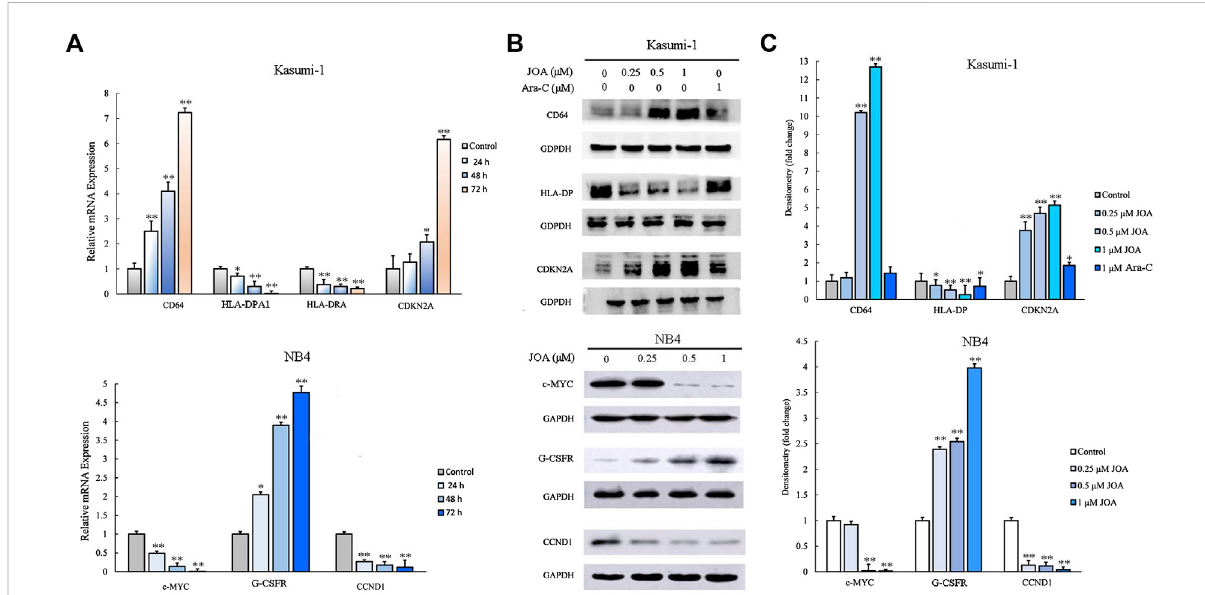
MolecularanalysisoftheeffectsofJOAondifferentiation-relatedgenesinKasumi-1andNB4cells. (A) EffectofJOAonthemRNAexpressionof CD64, HLA-DPA1, HLA-DRA, and CDKN2A in Kasumi-1 cells and c-MYC, G-CSFR, and CCND1 in NB4 cells. The cells were incubated with 1 μ M of JOAfor24,48,or72 h. (B) EffectofJOAonproteinexpressionofCD64,HLA-DP,andCDKN2AinKasumi-1cells,andc-MYC,G-CSFR,andCCND1in NB4 cells. The cells were incubated with JOA (0.25, 0.5, or 1 μ M) or Ara-C (1 μ M) for 72 h. (C) Graph bars showing the protein